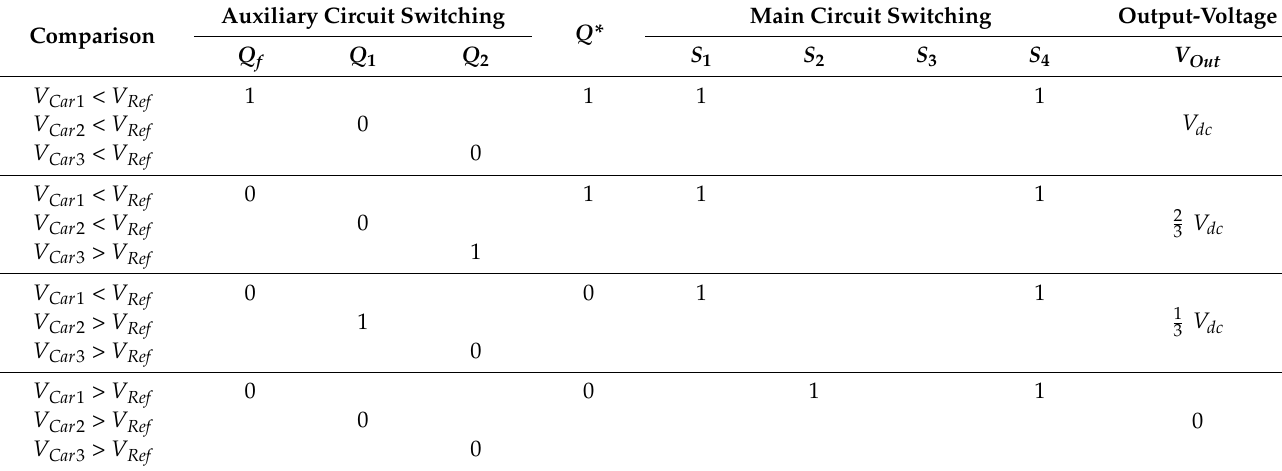
Table 1. Output voltage levels according to switching